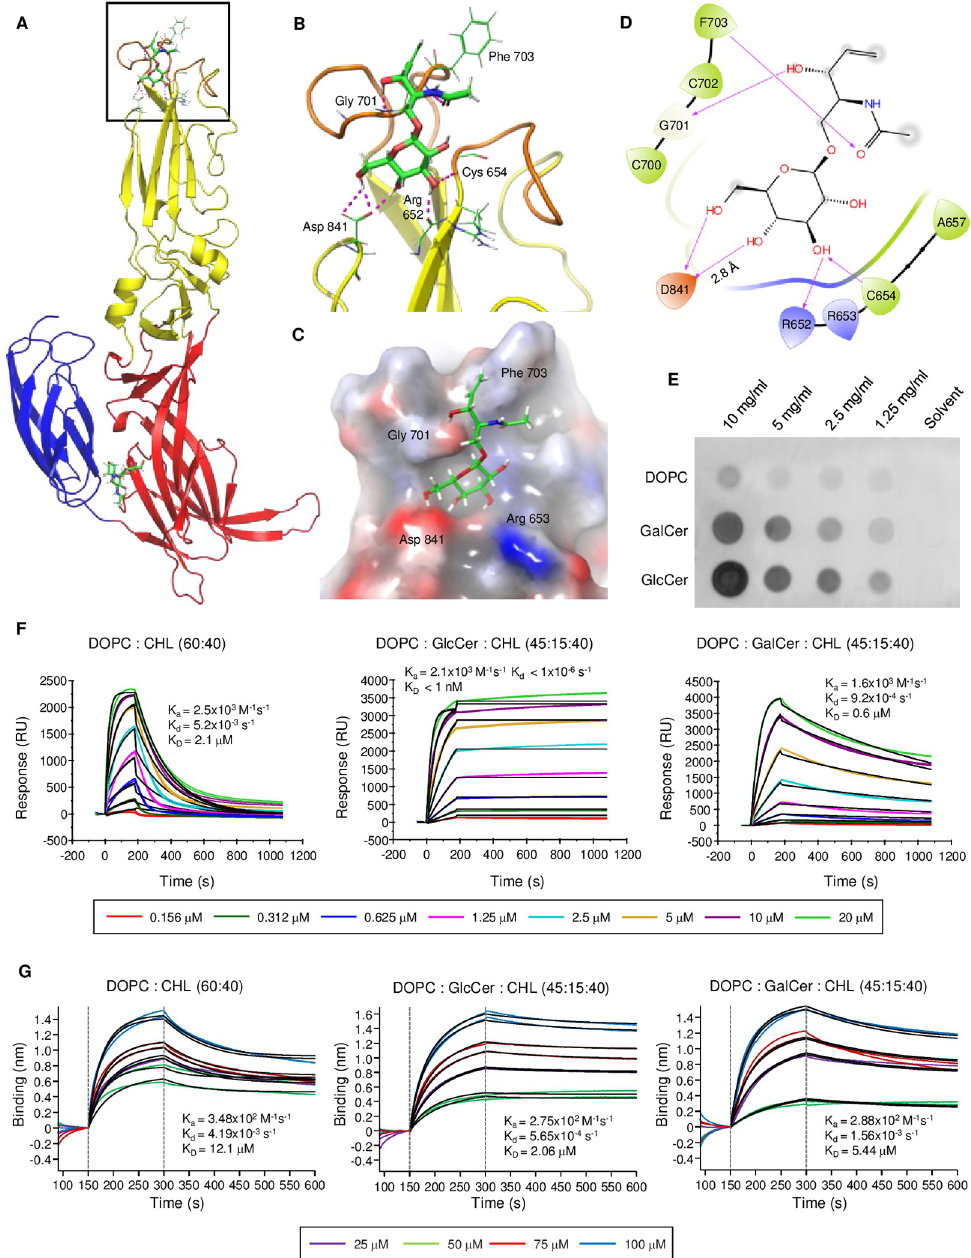
Fig 9. The HRTV Gc protein is associated with GlcCer in the lipid bilayer. A. Induced-fit docking pose of GlcCer with HRTV Gc protein. HRTV Gc ectodomain (PDB: 5YOW) is represented as ribbons and colored by domains (red, domain I; yellow, domain II; blue, domain III). The fusion loops at the tip of domain II are displayed in orange. The bound head group of GlcCer (framed) is drawn as sticks and colored according to atom type (carbon, green; nitrogen, blue; oxygen, red). B. Interaction of GlcCer with HRTV Gc protein in the lipid-head-group binding pocket. The hydrogen bonds between GlcCer and Gc protein are represented as dashed lines and colored in magenta. C. GlcCer binding groove. The HRTV Gc lipid-head-group binding pocket is shown in surface representation and colored according to electrostatic potential. D. 2D representation of docking interaction of GlcCer with binding site residues of HRTV Gc. The hydrogen bonds are shown in magenta lines. E. HRTV Gc protein directly binds to DOPC, GalCer, and GlcCer. Serially diluted DOPC, GalCer, and GlcCer were spotted onto the PVDF membrane. Protein-lipid overlay assay was performed with an anti-6xHis antibody. F. SPR assay of HRTV Gc binding kinetics to the indicated liposomes at neutral pH. All experiments were performed as duplicates, and the calculated fit is shown as a black line. Equilibrium constants (K D ) are determined by measuring the association rate constant (K a ) and dissociation rate constant (K d ). G. Binding kinetics of HRTV Gc